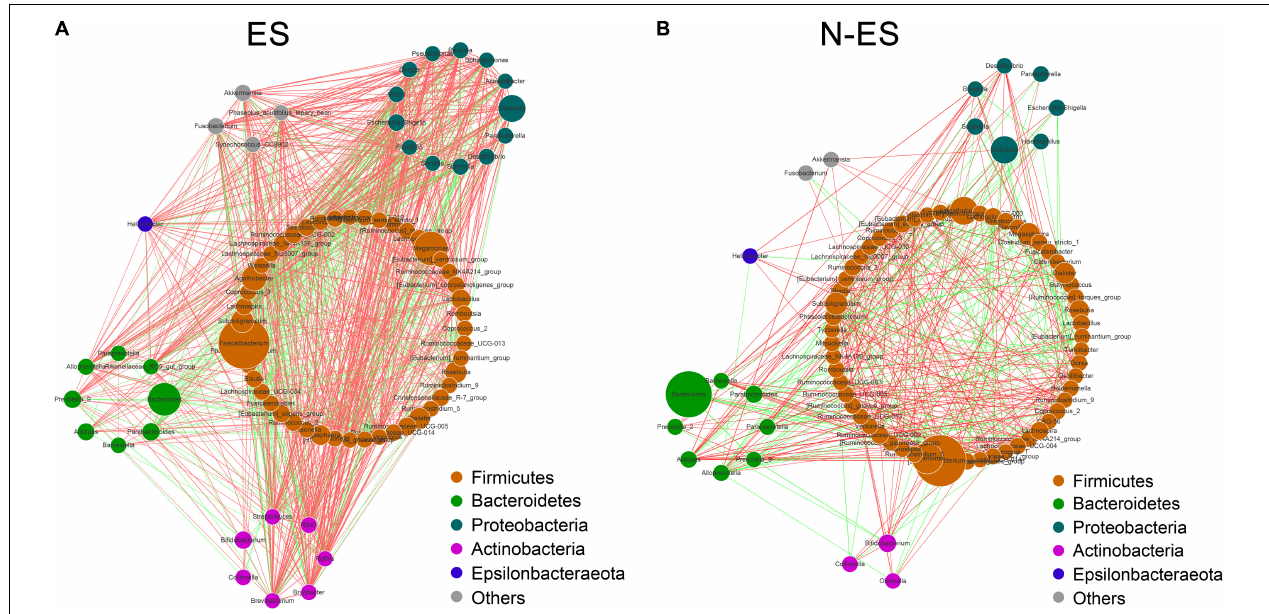
FIGURE 2 | The co-occurrence networks constructed based on relative abundances of genera in each group. (A,B) Genus–genus co-occurrence networks of ES (A) and N-ES (B) according to the Spearman correlation algorithms. Each node indicates a bacterial genus. The node size represents the relative abundance of these genera. Edges between nodes stand for positive (light red) or negative (light green) correlation, and the edge thickness indicates the Spearman